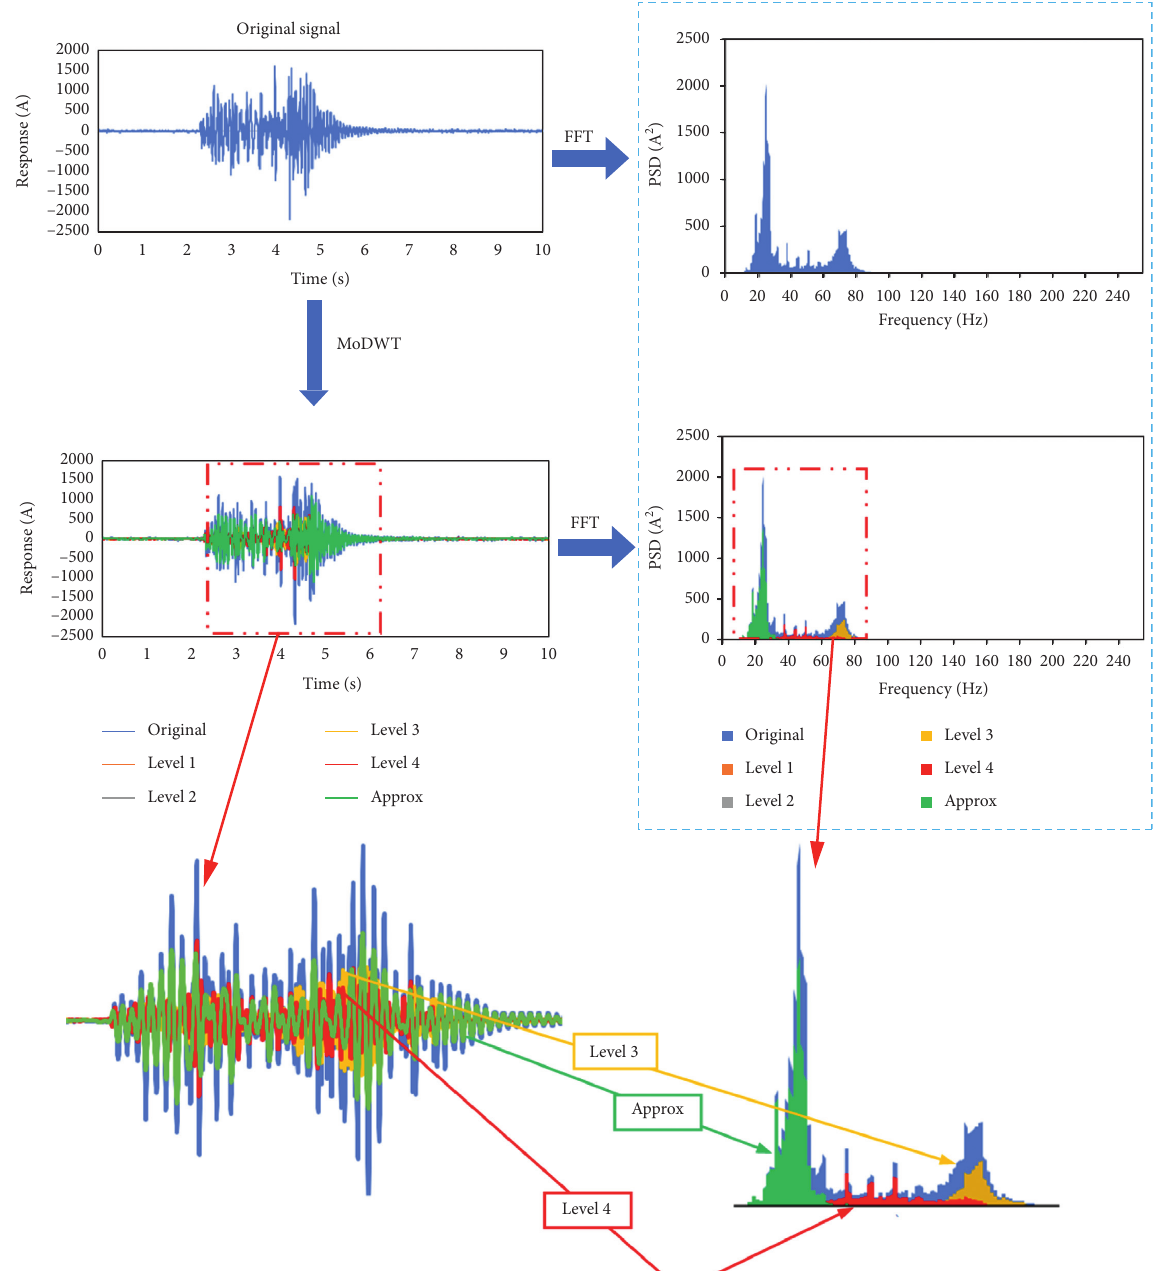
Figure 3: Spectral components analyzed by disaggregated